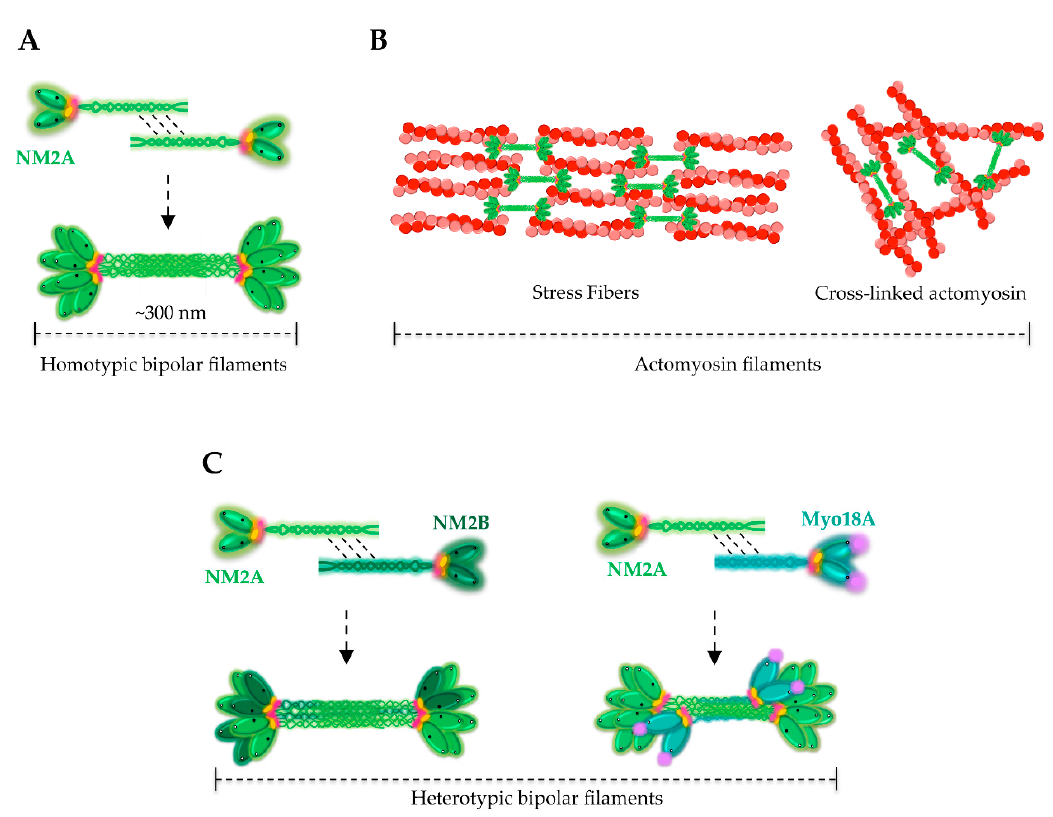
Figure 3. Mechanism of NM2 assembly and binding to actin filaments. ( A ) Assembly of homotypic bipolar filaments of NM2A. NM2A molecules interact antiparallelly by their tail regions and assemble into NM2A bipolar filaments of around 300 nm in length. The NM2A motor domains are oriented to the outside of the polymer and are free to interact with polymerized actin. ( B ) NM2A polymers bind to actin filaments building up stress fibers or more dynamic cross-linked actomyosin meshworks. ( C ) Assembly of heterotypic bipolar filaments. Different myosins are able to co-polymerize originating mixed filaments which may have different kinetic properties. Extra domains of Myo18A (purple, PDZ domain) may allow the interaction with additional proteins possibly increasing the layers of NM2 regulation.